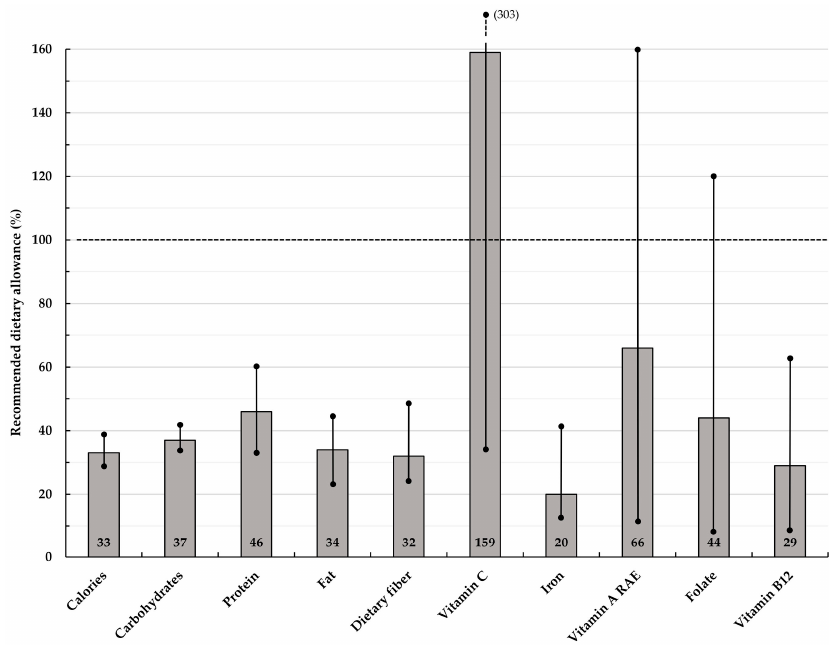
Figure 3. Mean contribution of lunch sets towards RDAs among non-pregnant women aged 19–30 years old. Lines within bars illustrate the range; RAE: Retinol activity equivalent.